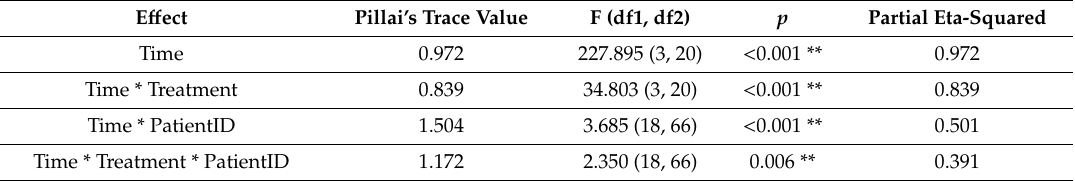
Table 8. Repeated measures ANOVA for the treatment and patient e ff ects over time (multivariate full factorial model).